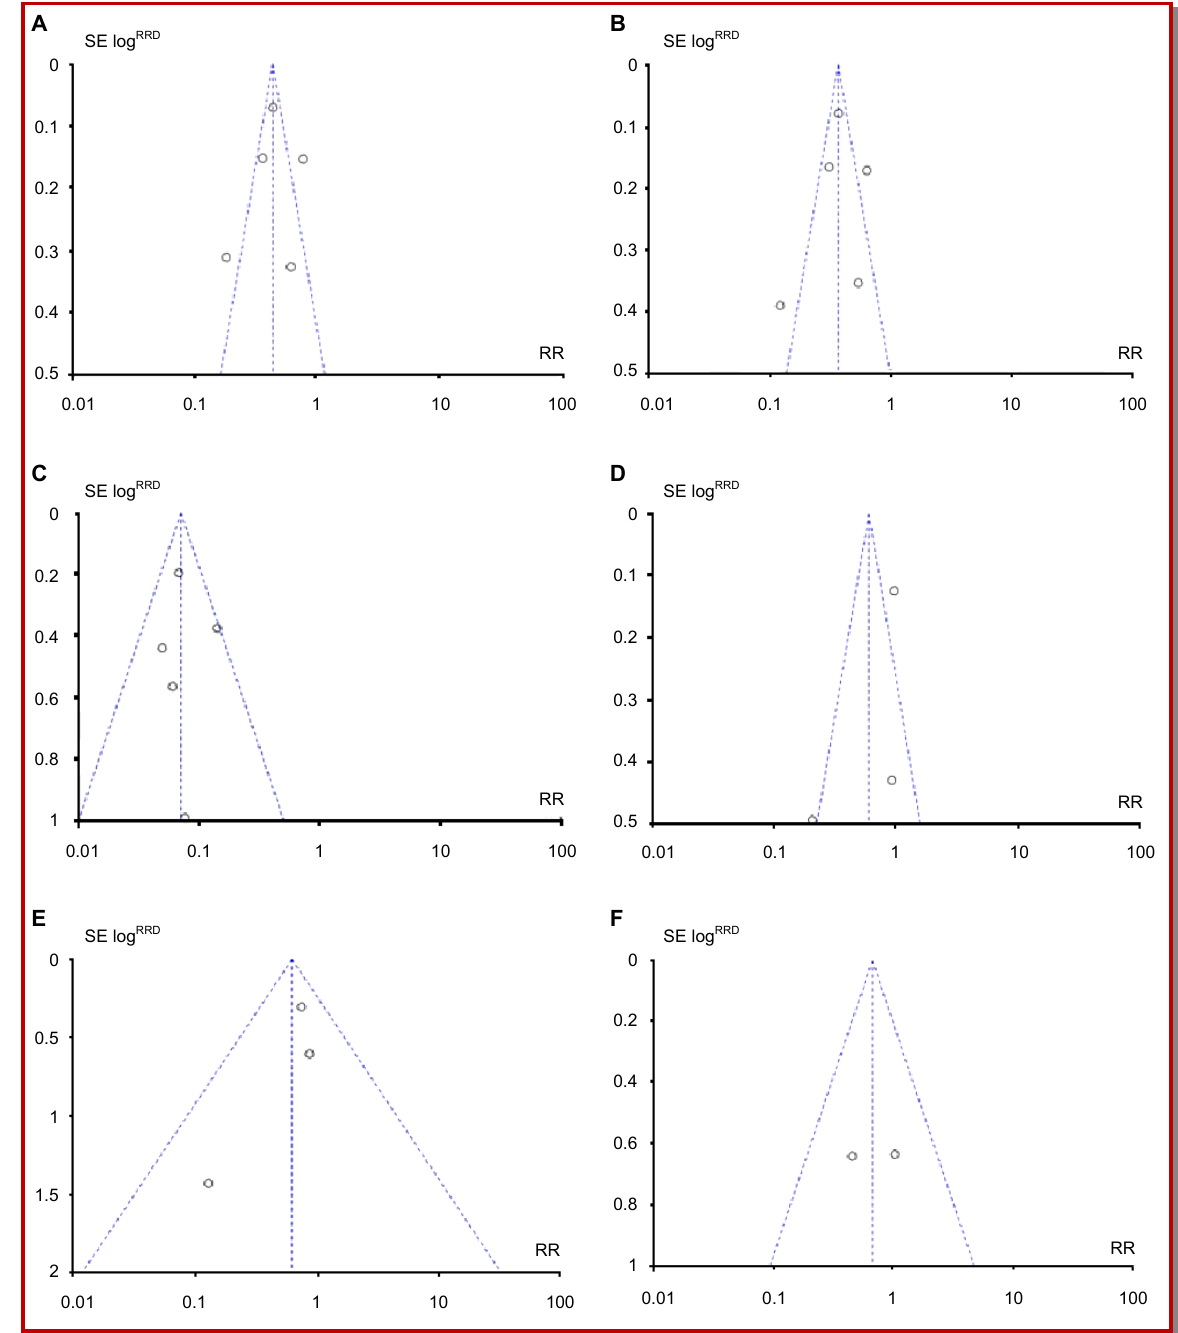
Figure 4: Publication bias TT/ TG vs GG (A), TT vs GG (B), TG vs GG (C), 2 years RFS (D), 5 years RFS (E), and 10 years RFS (F) of prostate